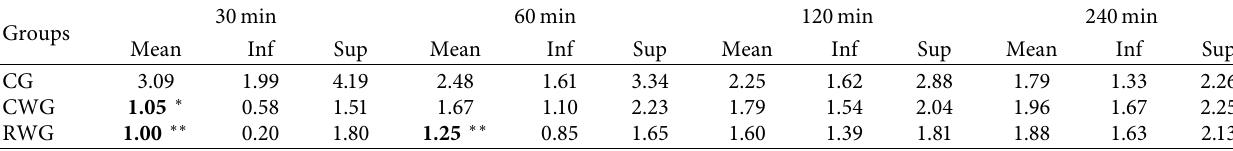
Table 4: Pain scores after awakening.